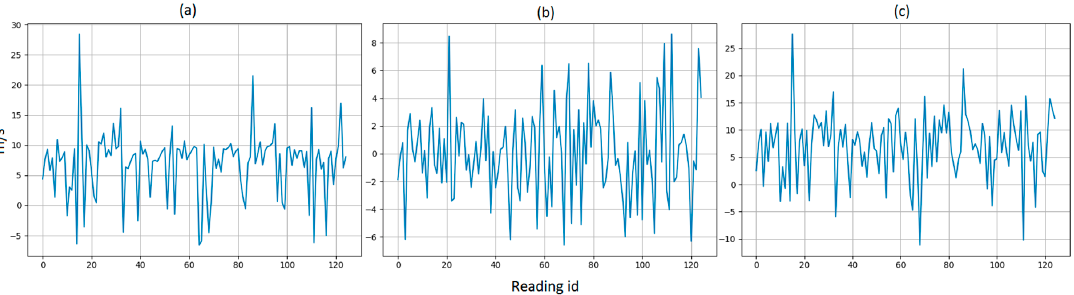
Figure 3. A sample for thermal noise simulation for one accelerometer axis in one instance with signal-to-noise ratio (SNR) of 5 dB. ( a ) Original sensor readings. ( b ) Added white noise. ( c ) New values with SNR = 5 dB. Table 2. Average inference accuracy with simulated thermal noise.